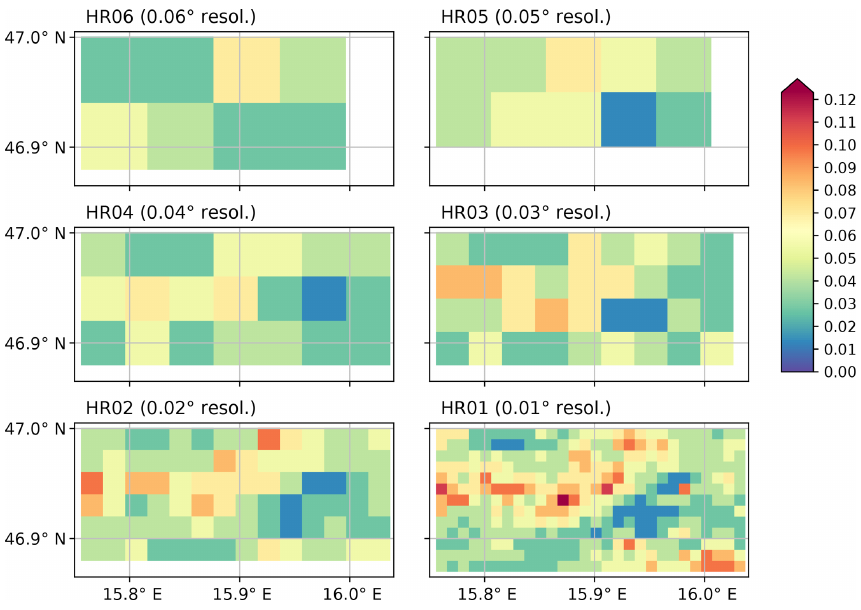
Figure 9. Occurrence of extreme events (defined as days with total rainfall ≥ 95th percentile of daily rainfall intensity during heavy rainfall events at HR01) at different horizontal grid spacings.